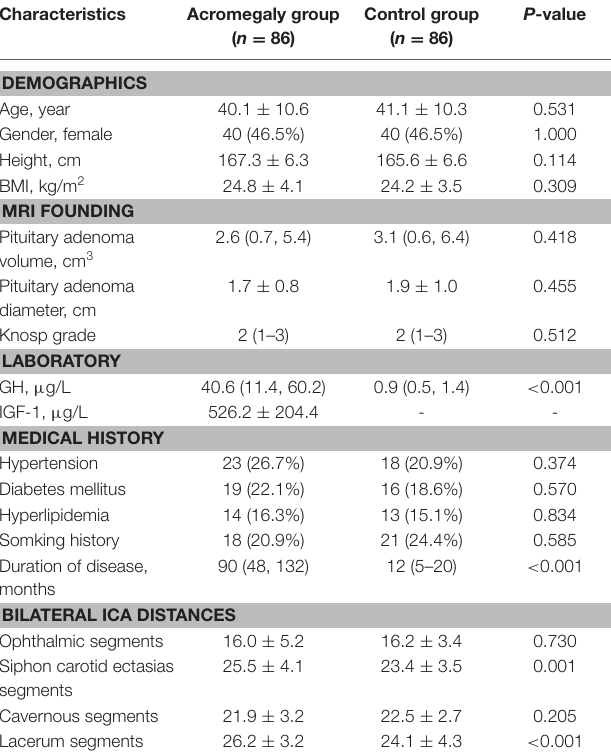
TABLE 1 | Comparison of demographic and clinical data between patients with acromegaly and non-functional pituitary adenomas.